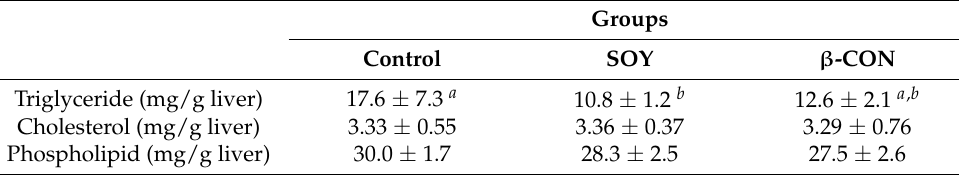
Table 3. Effect of dietary β -conglycinin on liver lipid concentrations in SHR.